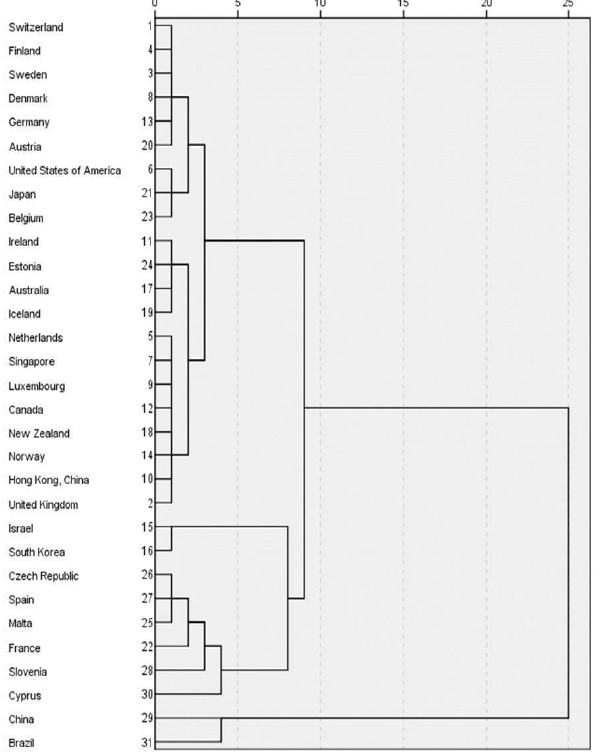
Figure 8 . Formation of Clusters of the Most Innovative Countries (in 2014) and Brazil‟s Position In 2014, China joined the group of the 30 most